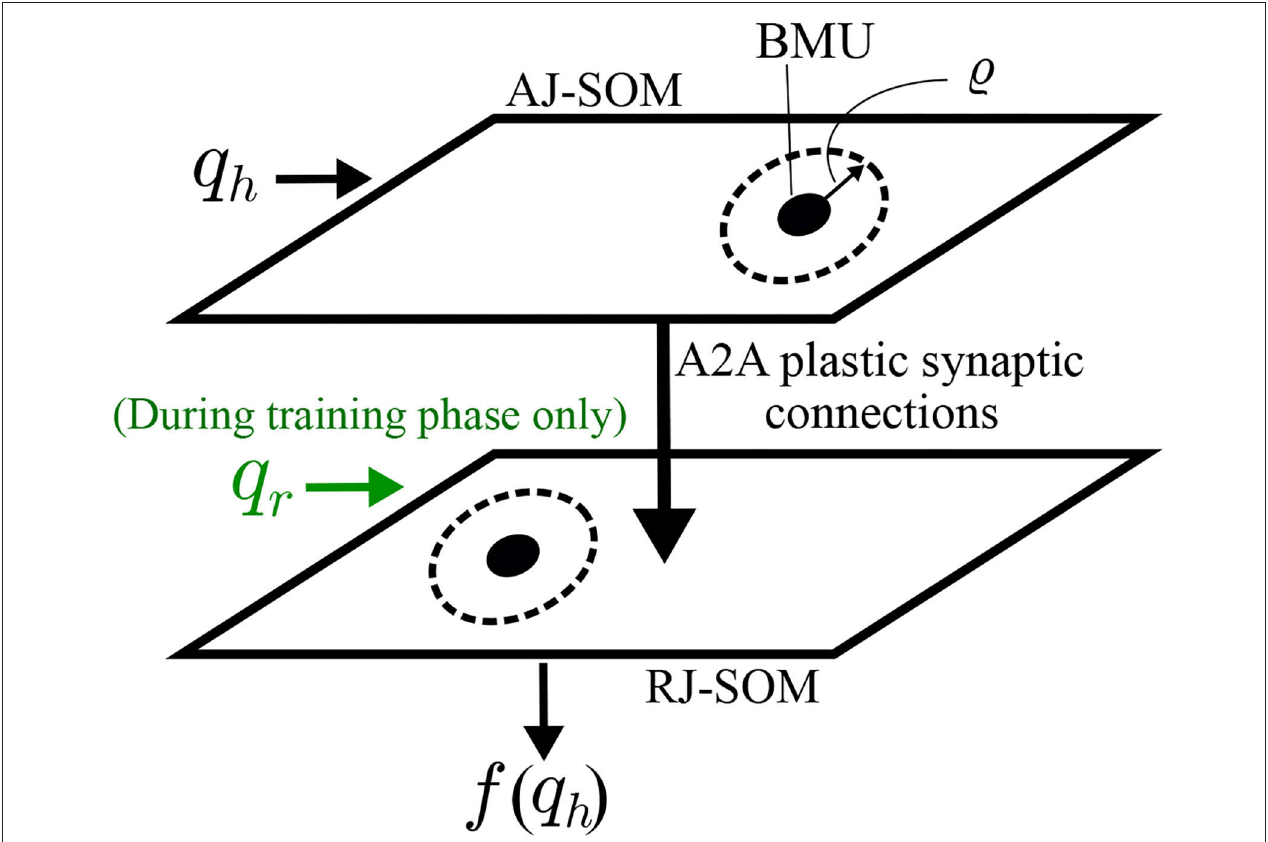
FIGURE 5 | Schematic diagrams for SOMs connected through Oja-Hebbian plastic synapses. This architecture allows correlating the joint spaces of the human arm and robot arm. During the training phase, BMUs (in AJ-SOM and RJ-SOM) from both maps that fire together are more likely to have an increase in strength of the connecting synapses. Consequently, during the control phase, if the same BMU in AJ-SOM becomes active, the corresponding node in RJ-SOM becomes active as